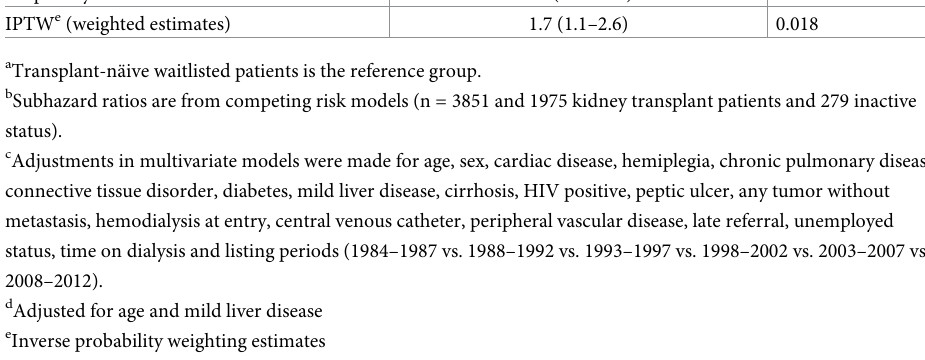
Table 4. Multivariate competing risk analysis for the relationship between post-graft failure and mortality in relisted patients for kidney transplantation a . Statistical models